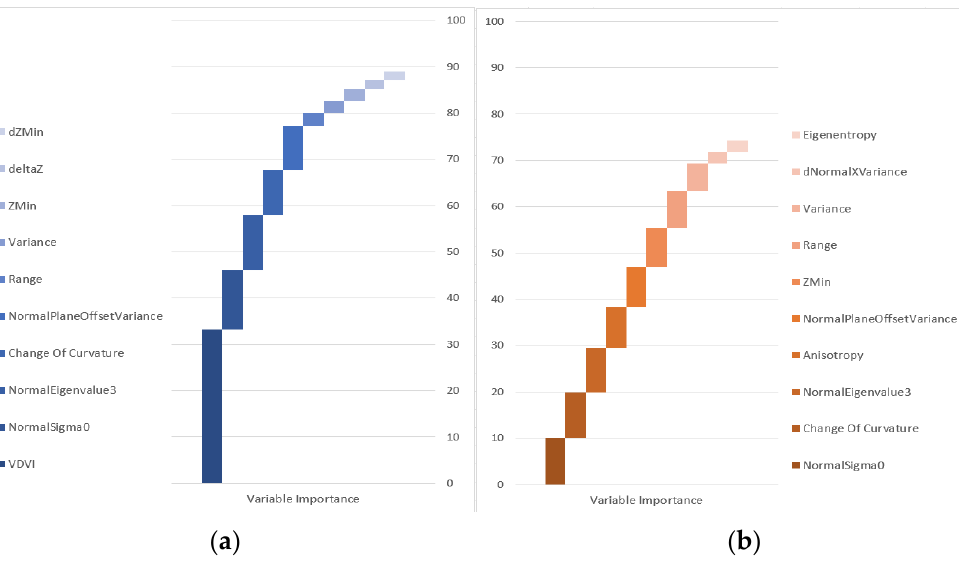
Figure 23. The variable importance for the RF models ( a ) with the VDVI attribute and ( b ) without the VDVI attribute.